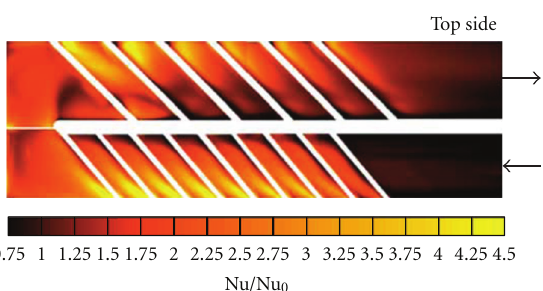
Figure 13: The local heat transfer characteristics on the wall with angled ribs measured by transient TLC thermography